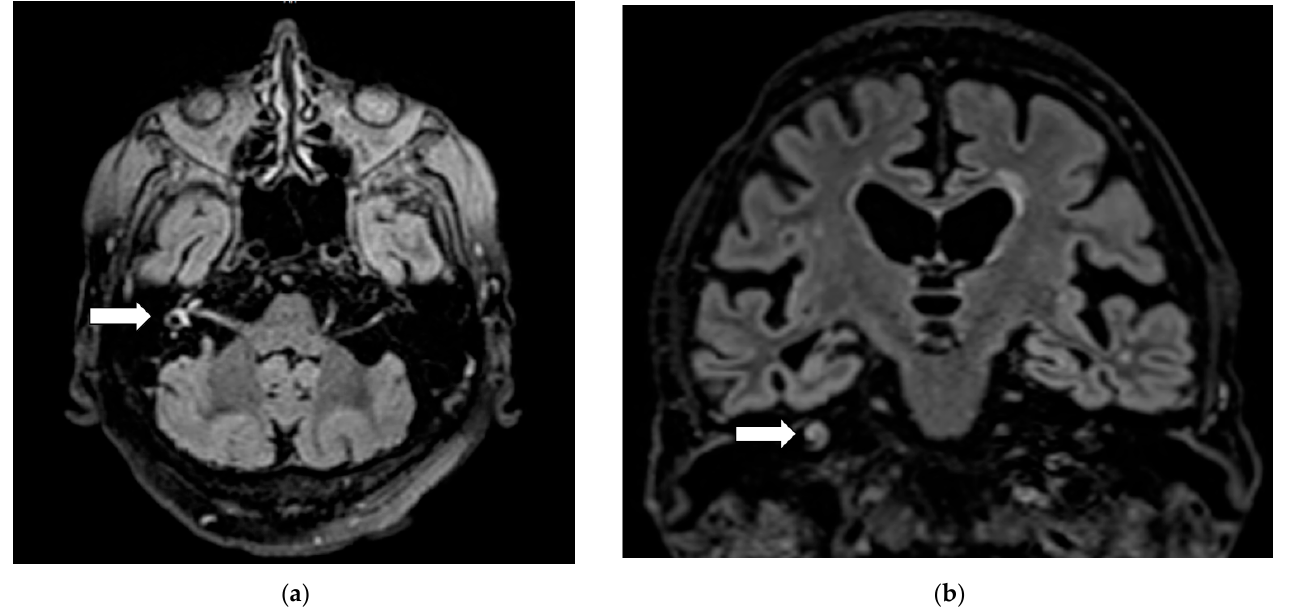
Figure 1. Right labyrinthitis: Hyperintensity (arrows) on axial ( a ) and frontal ( b ) FLAIR sections in right vestibule, semicircular canals and cochlear.